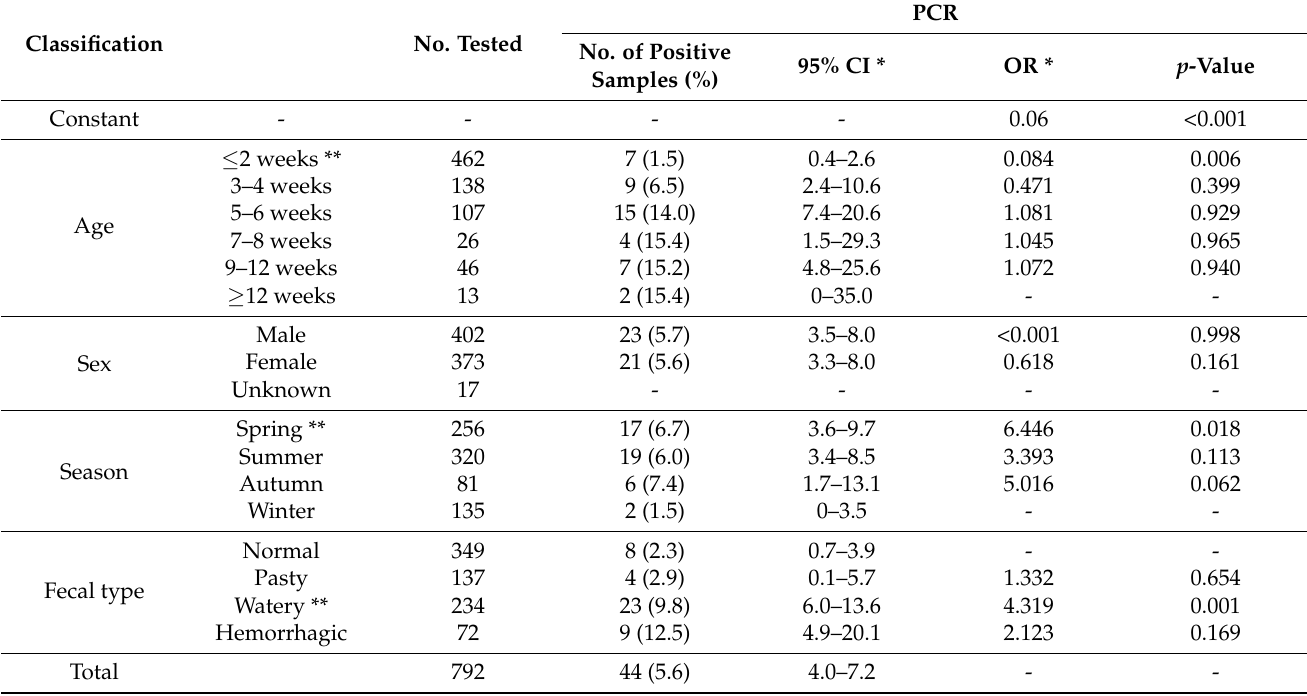
Table 1. Detection of Giardia duodenalis by PCR in the feces of 792 Korean native